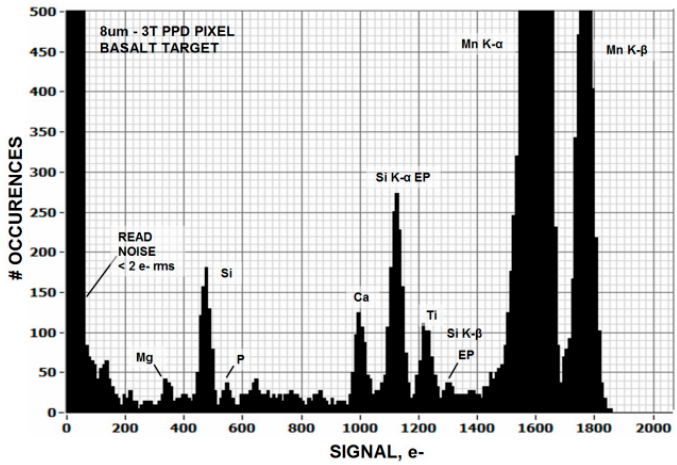
Figure 2. Photon counting and energy histogram generated by a 3T PPD CMOS pixel imager demonstrating Fano-noise limited performance over the entire soft X-ray regime.